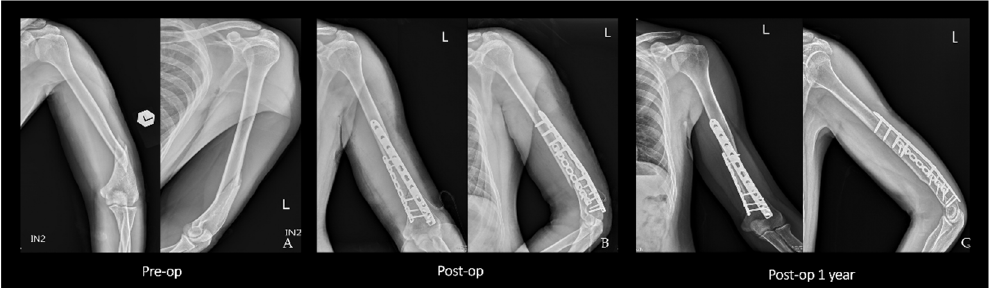
Figure 2. ( A ) Anteroposterior and lateral views showing a spiral fracture. ( B ) Postoperative radio- graphs showing the fixation with an AO LCP Metaphyseal Plate and AO Reconstruction LCP Plate using a triceps-sparing approach. ( C ) One-year postoperative radiographs revealing bone union. Abbreviations: LCP = locking compression plate. L= left.